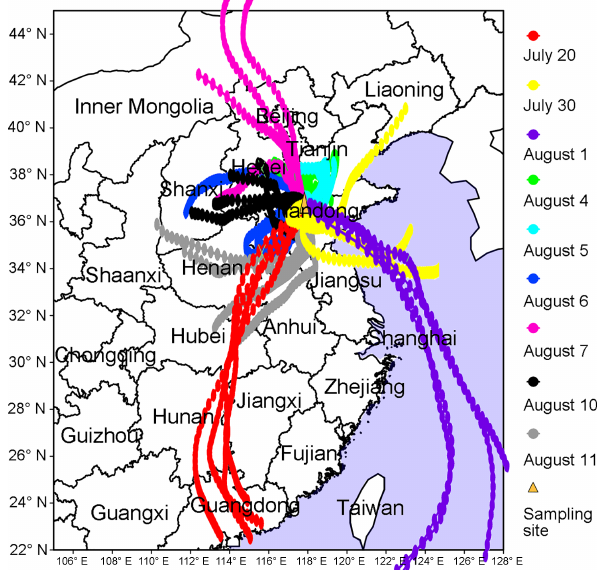
Figure 4. The 48h backward trajectories calculated every 6h, with Jinan (36.68 ◦ N, 117.07 ◦ E; 500ma.g.l.) as the ending point. The trajectories are simulated by HYSPLIT v4.9. The water areas are highlighted in